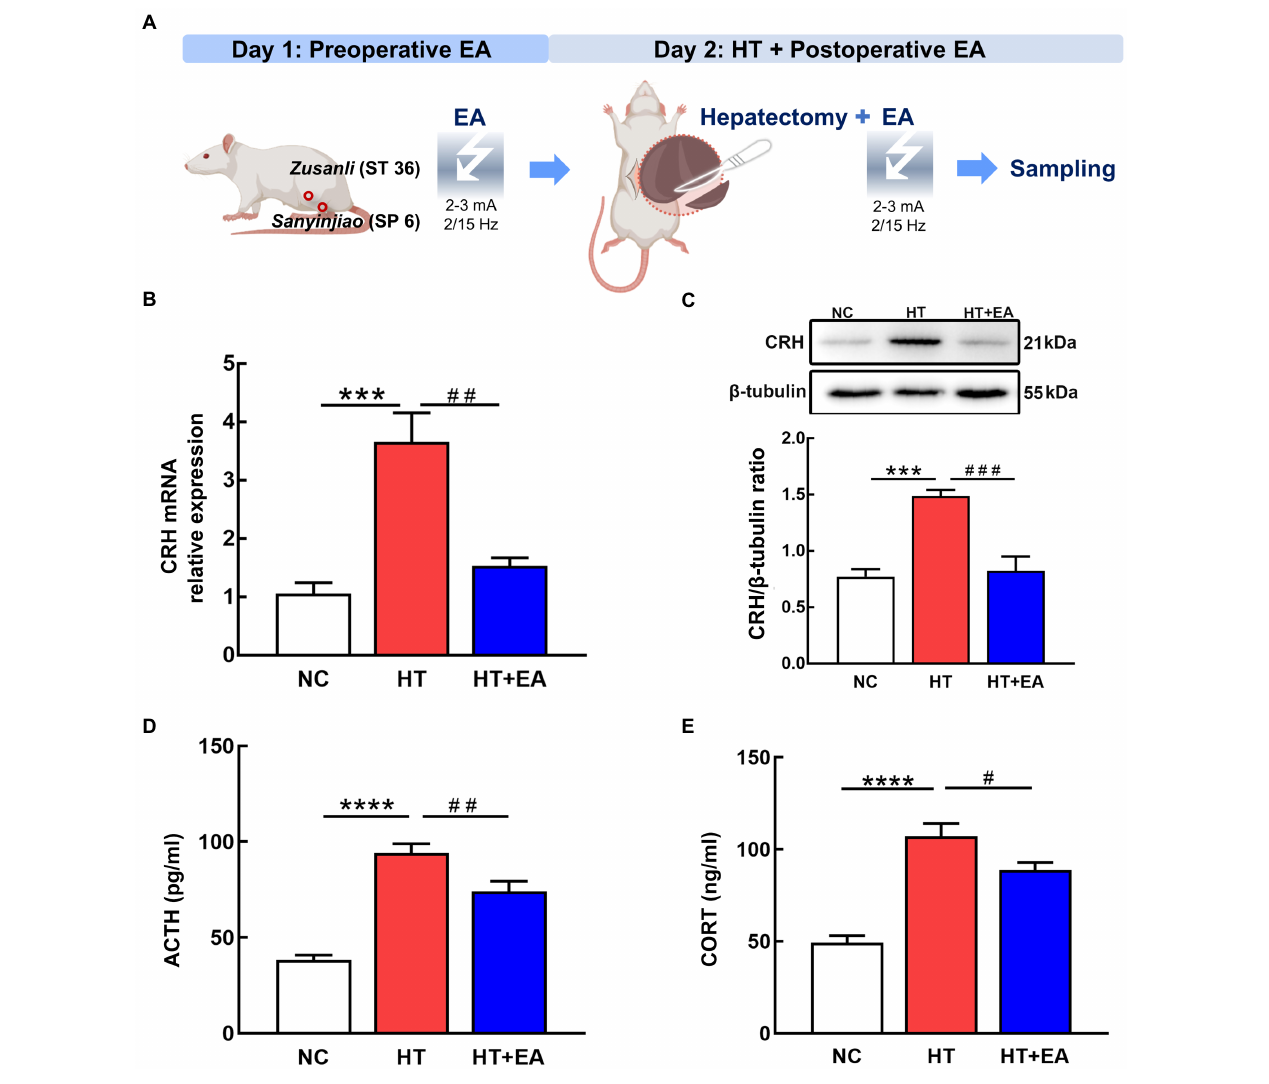
FIGURE 1 EA relieved the surgery-induced hyperactivity of the HPA axis. (A) Flow chart of the HT-induced stress rat model and EA treatment. (B,C) Quantification of CRH mRNA and protein detected by RT-PCR and western blot. (D,E) Serum levels of ACTH and CORT as measured by ELISA. Data are shown as the mean ± SEM. * p < 0.05, ** p < 0.01, *** p < 0.001, **** p < 0.0001, versus the NC group. # p < 0.05, ## p < 0.01, ### p < 0.001, and #### p < 0.0001 versus the HT